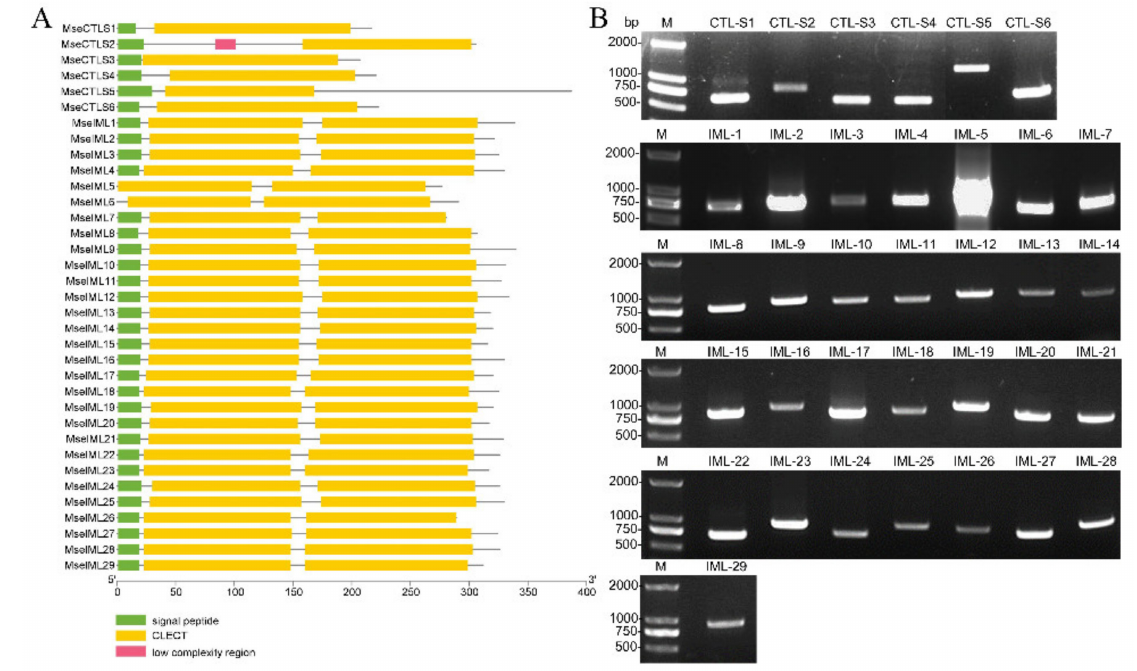
Figure 4. Domain architecture and PCR amplification of M. separata CTLs: ( A ) domain architecture of CTLs was analyzed by SMART (http://smart.embl-heidelberg.de/) (accessed on 10 May 2021); and ( B ) CTL genes were amplified using primers in Table S1 and analyzed on 1% agarose gel.